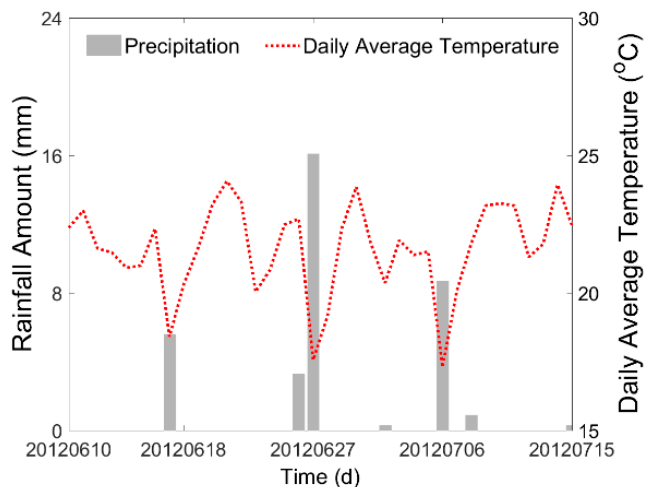
Figure 3. Precipitation condition and daily average temperature of the study area from 10 June 2012 to 15 July 2012.